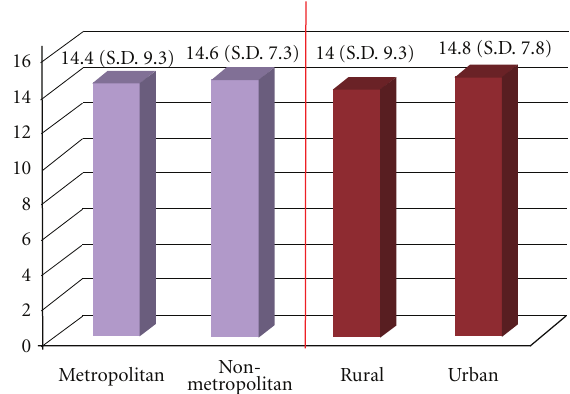
Figure 1: The mean OHIP-14 score (SD) according to region. Correlations and significances are shown.